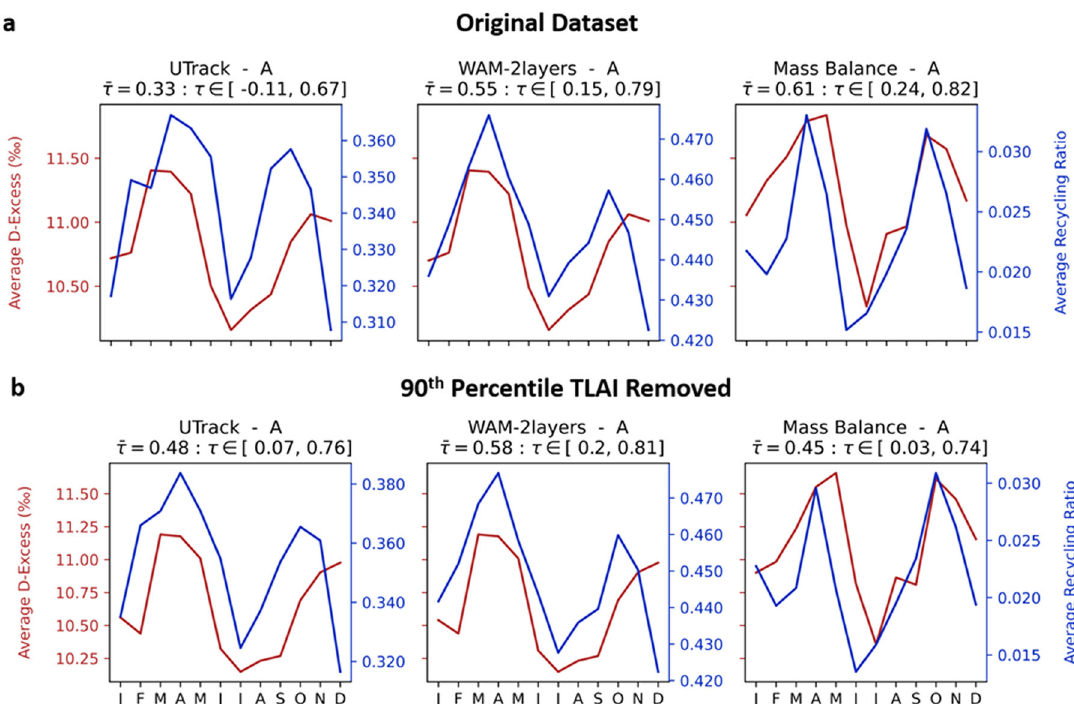
Fig. 4 Climatological comparison with dense vegetation outliers removed. The overall tropical climatological comparison from Fig. 3a is replicated in panel ( a ). Panel ( b ) shows an identical analysis, but where observations which are associated with the >90th percentile of total leaf area index (TLAI) are removed from the analysis.